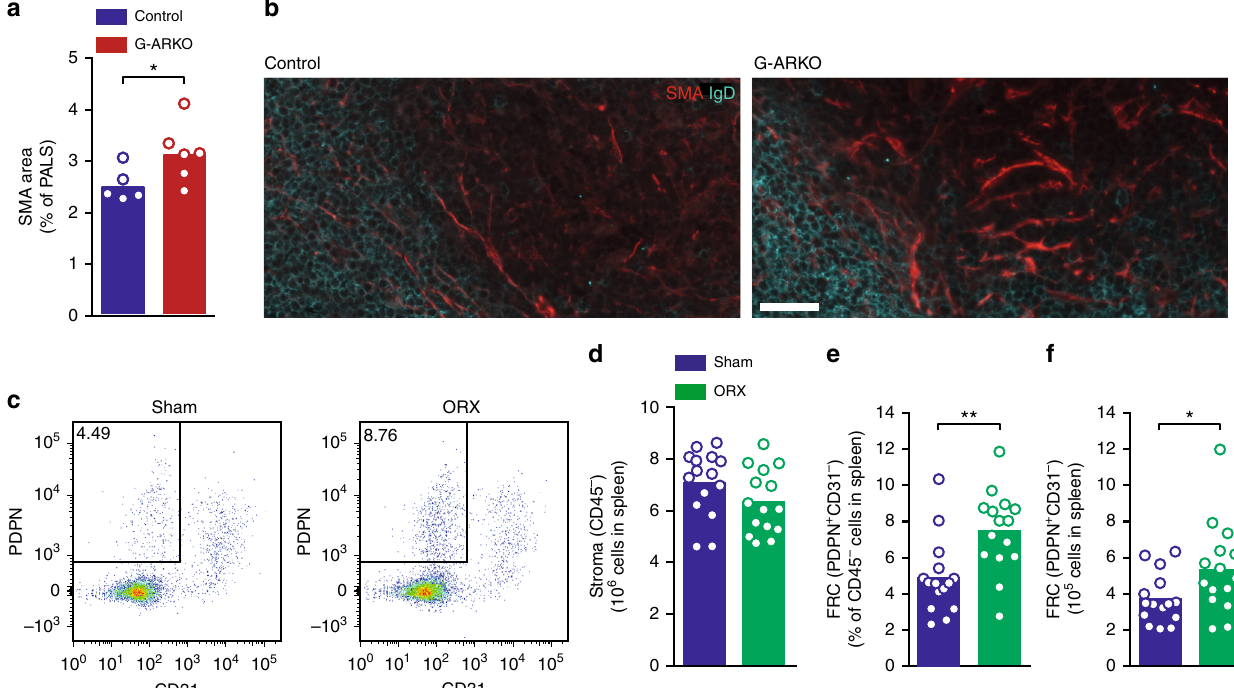
Fig. 5 Expansion of FRCs in testosterone/AR de fi ciency. a Quanti fi cation of smooth muscle a-actin (SMA)-stained area, expressed as percentage of peri- arteriolar lymphoid sheath (PALS) area in control ( Pgk-Cre + ) and general androgen receptor knockout (G-ARKO) male mice. n = 5 – 6/group. b Section of spleens from control and G-ARKO male mice, at the border of the B cell zone and PALS area. Red, SMA-positive fi broblastic reticular cells (FRC); turquoise, IgD-positive B cells. Scale bar, 30 µ m. c Representative plots of PDPN + CD31 – CD45 – FRCs in the spleen from sham-operated and castrated (ORX) male mice 2 weeks after surgery. d Total number of CD45 – cells in spleens of castrated or sham-operated male mice. n = 15/group. e Frequency of FRC among stromal (CD45 – ) cells and f total FRCs per spleen in ORX and sham-operated male mice. Bars indicate means; circles represent individual mice.* P < 0.05, ** P < 0.01 (Mann – Whitney